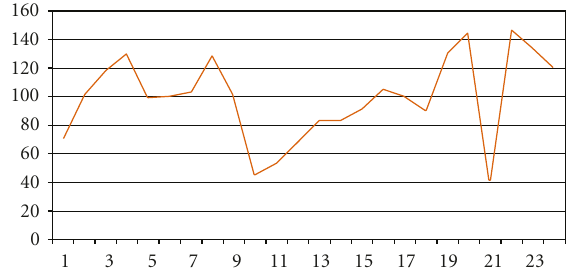
Figure 33: Net load o ff set between load and renewable output.